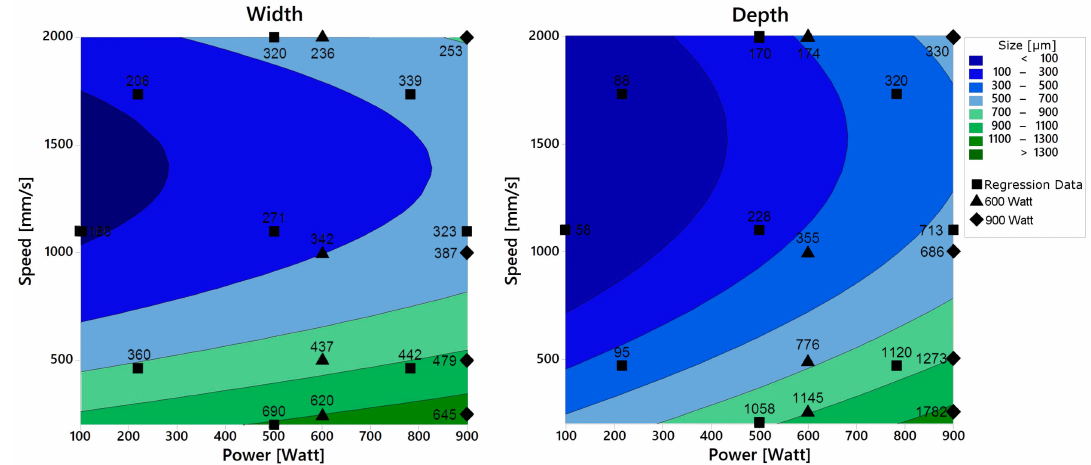
Figure 6. Melt pool width and depth for primary laser tracks . Topographical representation is based on the regression data. Data points of the full factorial design, which were used for the regression, are marked by squares. Data points of the single parameter variations marked by triangles and